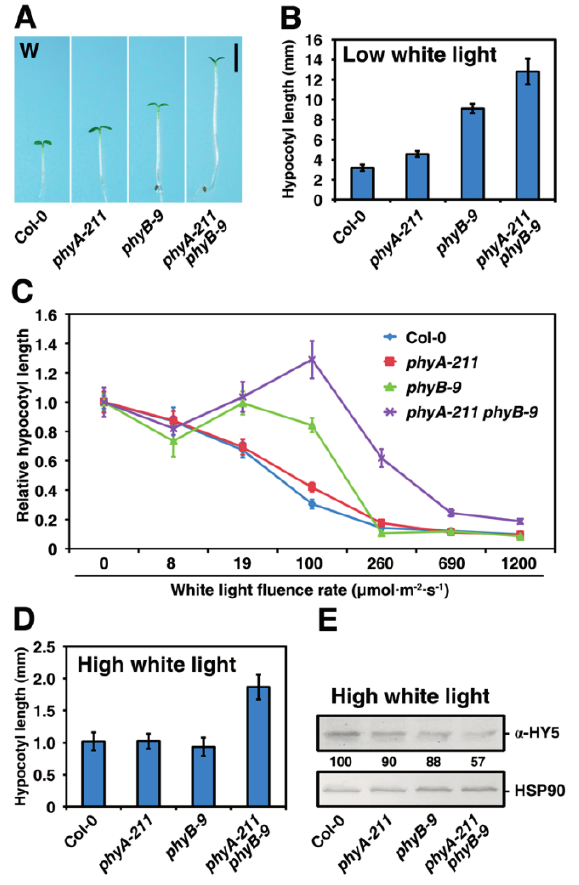
Figure 3. PhyA and phyB synergistically promote de-etiolation under white (W) light. ( A ) Morphology of the WT Col-0, phyA-211 , phyB-9 and phyA-211 phyB-9 grown under low W (100 μ mol·m − 2 ·s − 1 ) light for four days. Bar = 2 mm; ( B ) Quantification of hypocotyl lengths of seedlings shown in A. The means of three replicates (at least 30 seedlings each replicate) are shown ± SE; ( C ) PhyB shows a synergistic effect with phyA to promote seedling de-etiolation responses under W light of different intensities. The means of three replicates (at least 30 seedlings per replicate) are shown ± SE; ( D ) Quantification of hypocotyl lengths under high W light (1200 μ mol·m − 2 ·s − 1 ). Error bars indicate standard deviations. The means of three replicates (at least 30 seedlings each replicate) are shown ± SE; and ( E ) Immunoblot analyses of HY5 in seedlings shown in ( D ). An anti-HSP90-specific immunoblot, indicating approximately equal loading, is shown at the